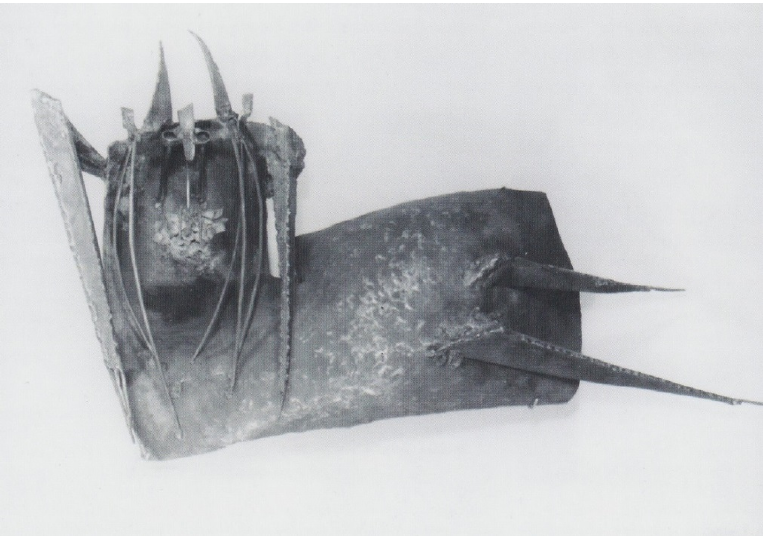
Figure 1. Leon Podsiadły, Nocny gość [ Night Visitor ], 1959, metal. After: (Wąs 2012a, p. 33). Photo used with the permission of the artist’s family. used with the permission of the artist’s